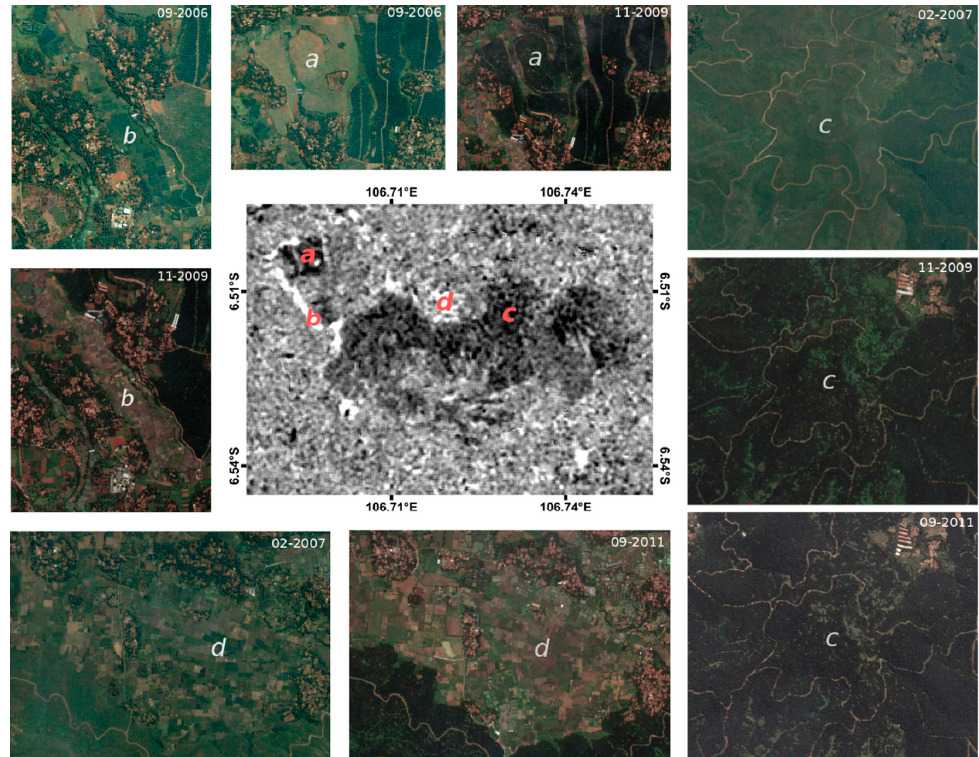
Figure 5. The binary image resulting from the Gamma ‐ Map Filter of MAD variate ‐ 2 and historical Google Earth images in the proximate acquisition of ALOS PALSAR. A change from fields prepared for cultivation to land fully ‐ covered with oil palm ( a ) or from juvenile to maturing oil palm plantation ( c ). The light tone signified the inverse condition from vegetated crop areas to semi ‐ bare ones as indicated in ( b , d ).